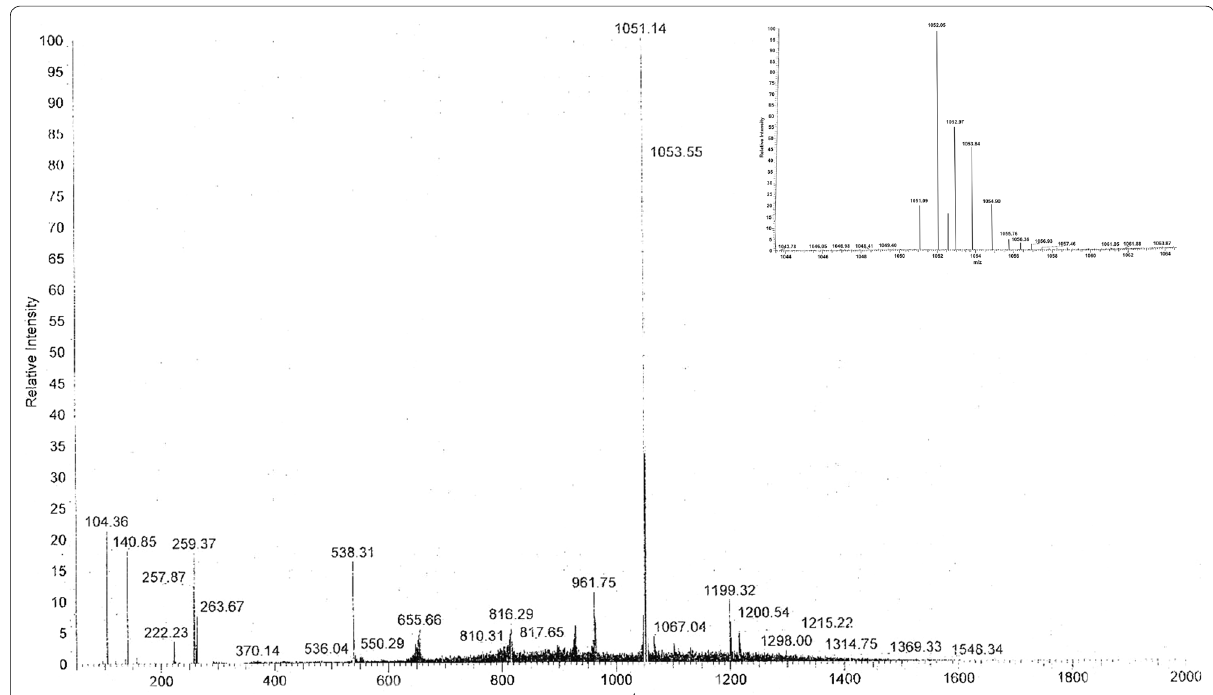
Fig. 4 Analysis of the bacteriocin-like compound by mass spectrometry. Full scan mass spectrum of the extract in positive ESI ion detection mode with one main fragment showing m/z